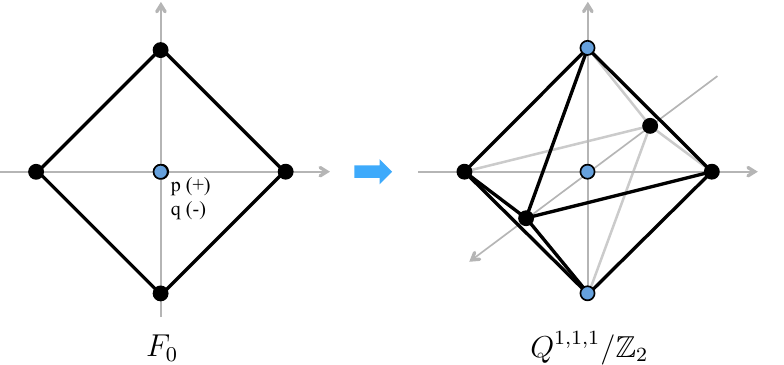
Figure 16. The toric diagram for Q 1 ; 1 ; 1 = Z 2 , obtained by lifting central perfect matchings of F 0 in opposite